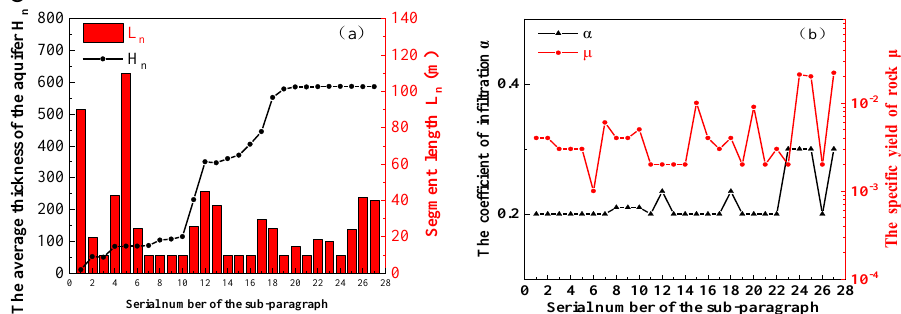
Figure 6. Distribution of parameters by segments. ( a ) Ln and Hn; ( b ) µ and α .